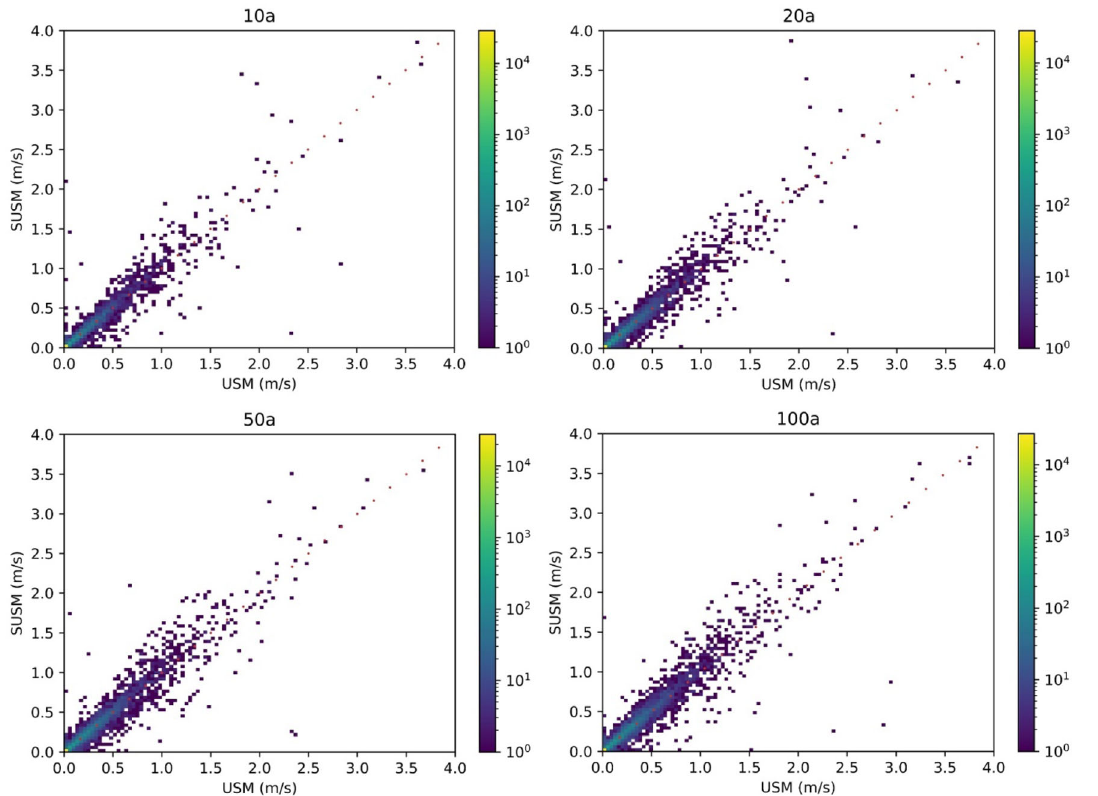
Fig. 13 2D histograms of flow velocity, which present the density of raster cells in the four rainfall return periods. The x- and y -axes represent the flow velocities simulated by the urban stormwater model (USM) and simplified urban stormwater model (SUSM),